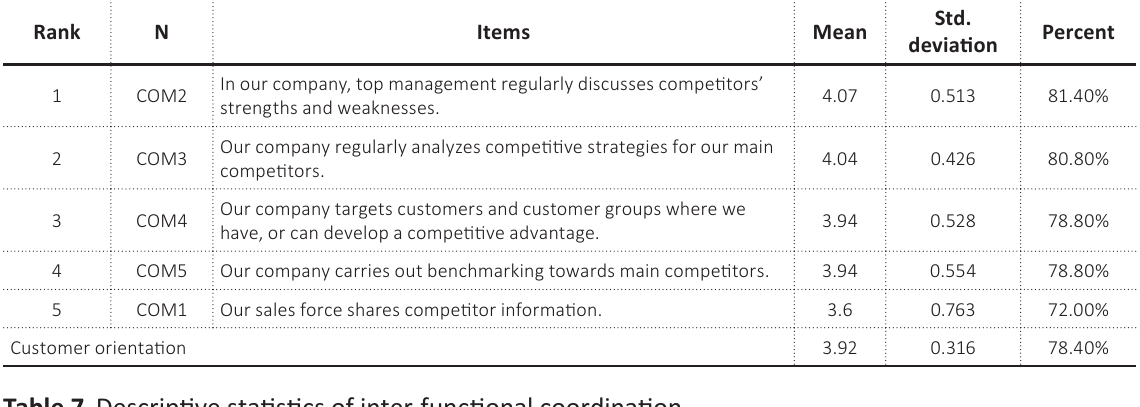
Table 7. Descriptive statistics of inter-functional